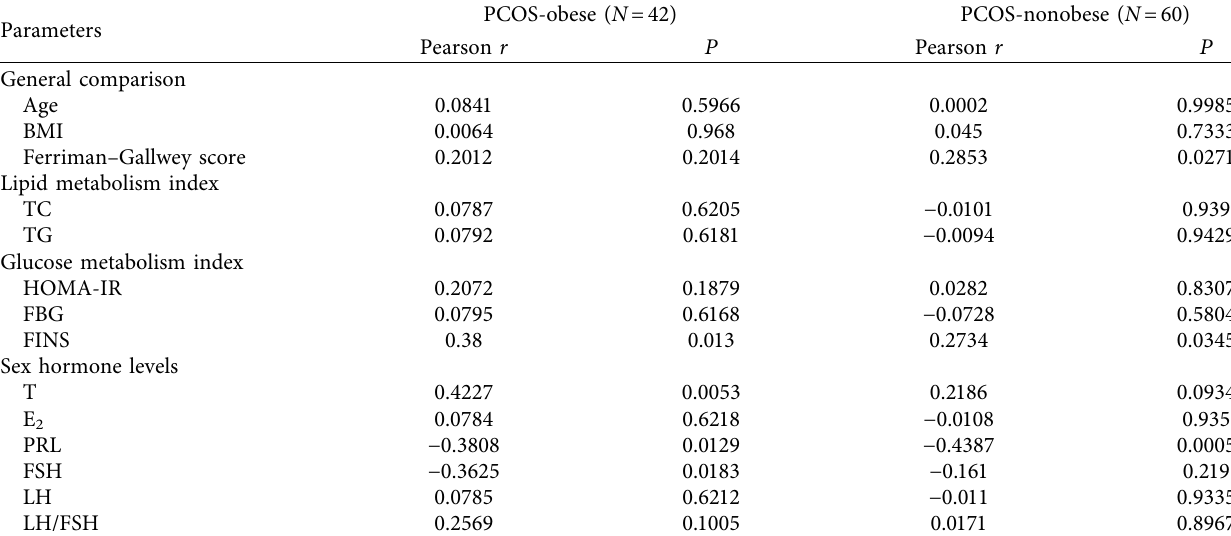
Table 4: Relationship between the expression of ANGPTL2 in serum and the clinicopathological features of obese and nonobese PCOS